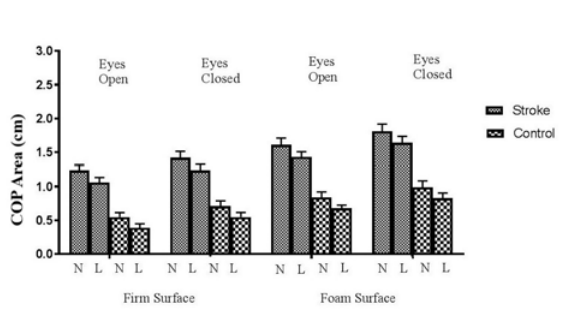
Figure 2: The area of center of pressure in the two groups for each condition. N, no touch; L, light